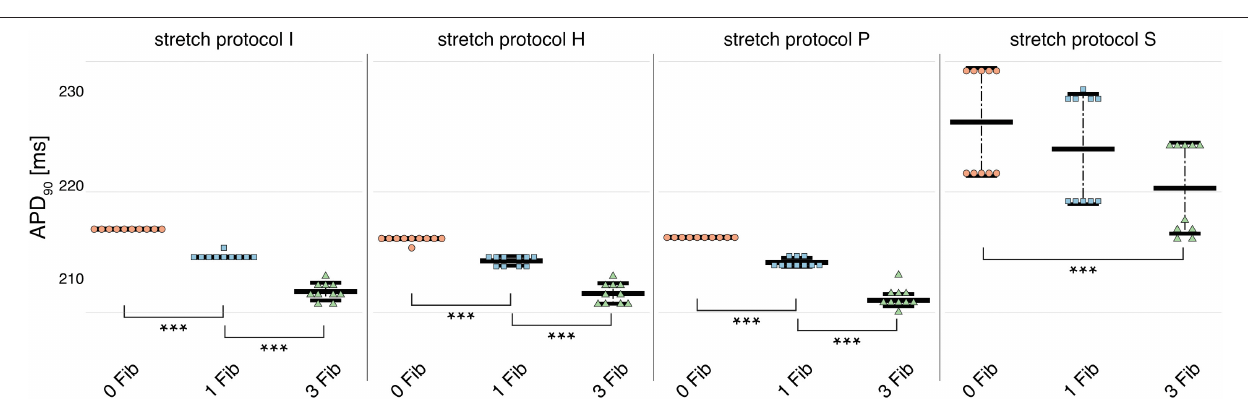
FIGURE 4 | APD 90 for simulations of myocytes with no (red data points), 1 (blue data points), and 3 coupled fibroblast (green data points) compared with control (no coupled fibroblast) for no contraction and stretch patterns H, S, and P. APD 90 was significantly reduced for all simulations of myocytes with coupled myocytes for the different stretch